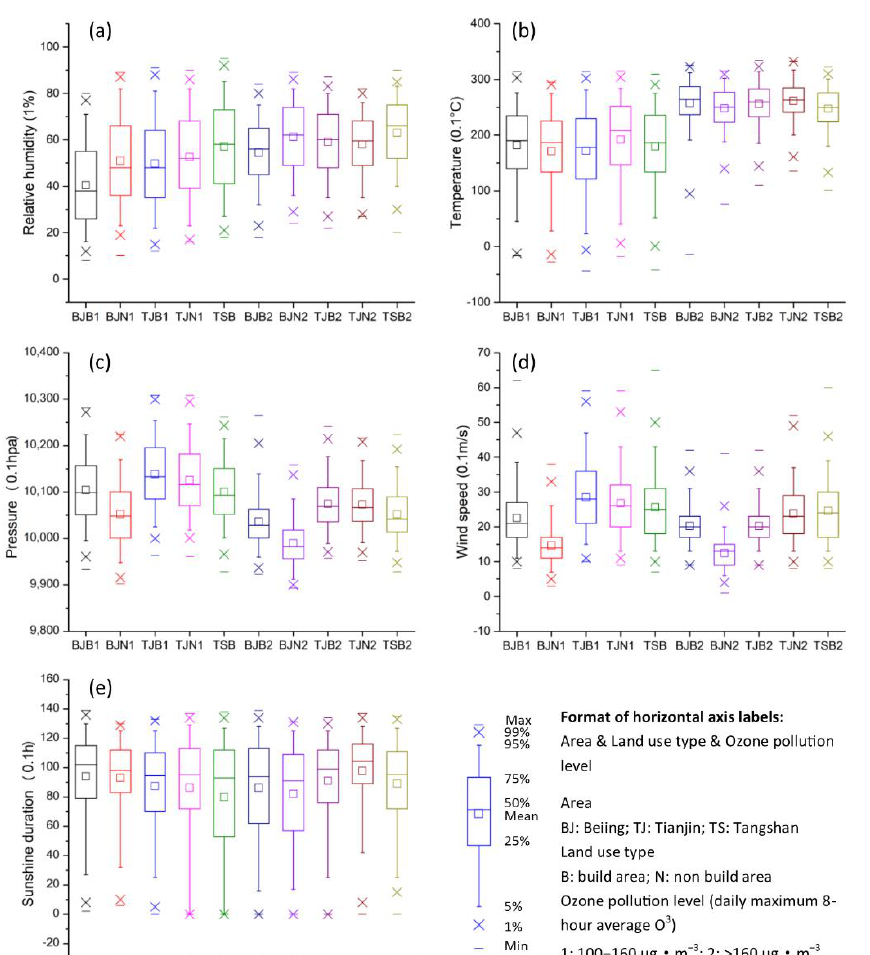
Figure 5. Meteorological factors associated with different MDA8 levels: ( a ) Relative humidity, ( b ) Temperature, ( c ) Pressure, ( d ) Wind speed, and ( e ) Sunshine duration. Note: The boxes encompass the 25th – 75th percentiles and contain median lines.